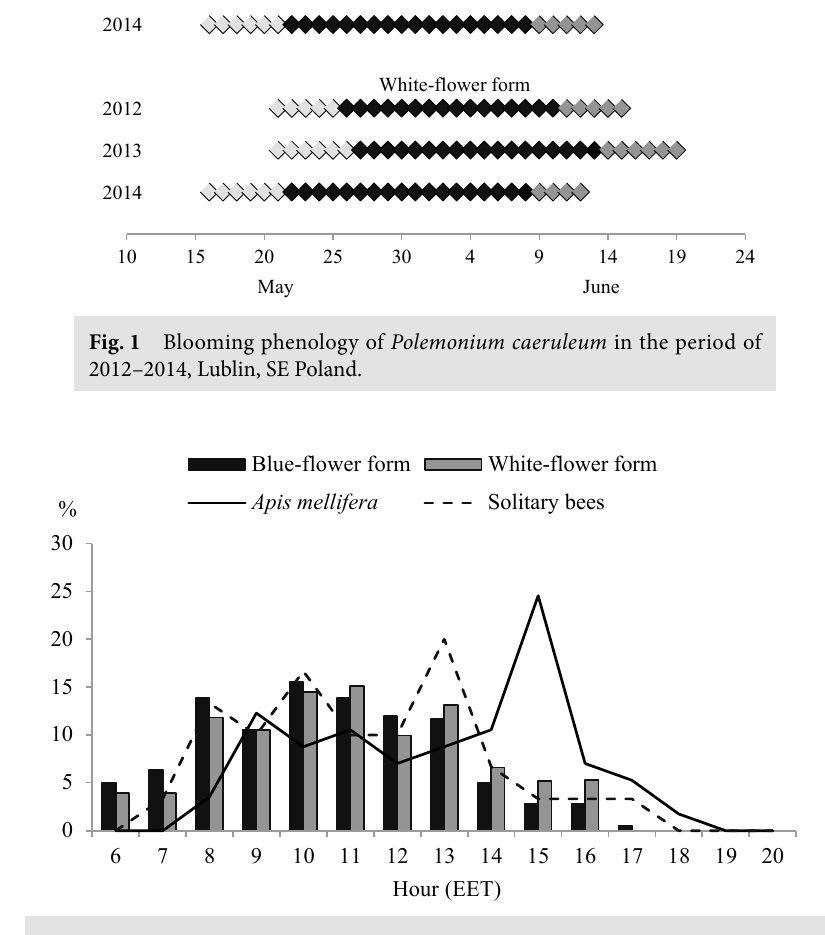
Fig. 2 Diurnal pattern of blooming in two forms of Polemonium caeruleum expressed as the number of flowers opened at 1-h intervals in relation to the total number of flowers opened during the day and the diurnal activity of insect visitors observed in Lublin, SE Poland. Data represent means calculated from 2012–2014; EET – Eastern European